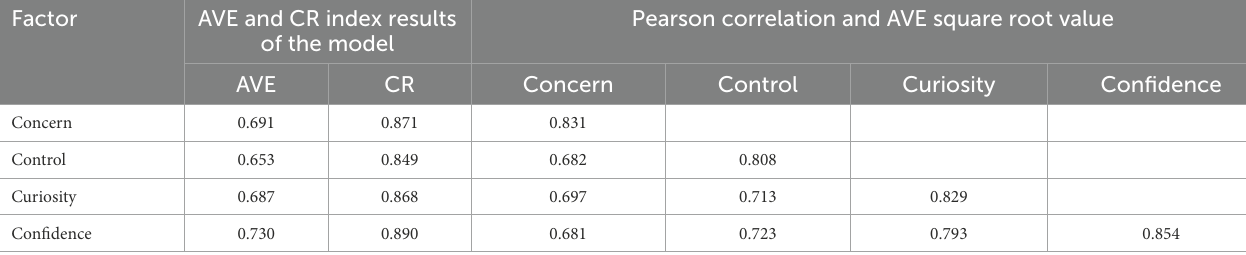
TABLE 3 The CFA Results of CAAS-SF China.